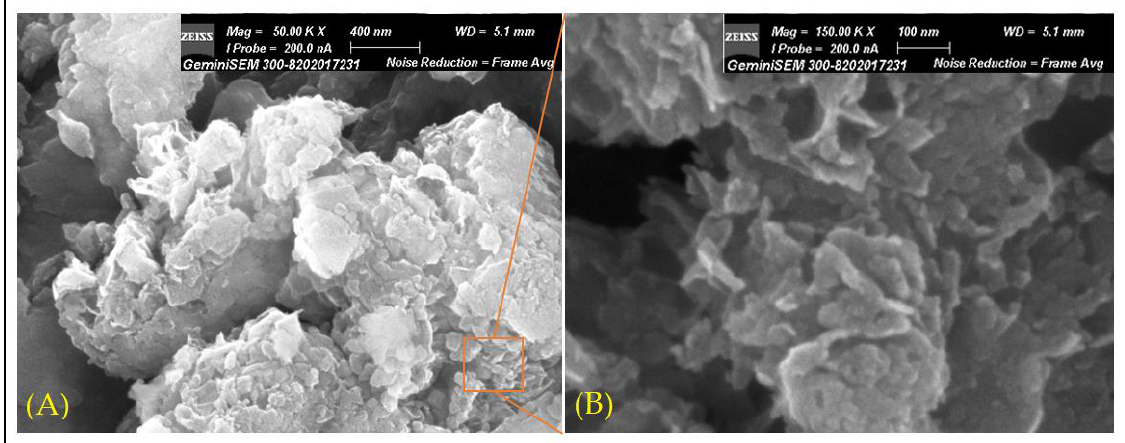
Figure 8. FESEM images 9 wt% g-C 3 N 4 /MoS 2 at magnifications of 400 nm ( A ) and 100 ( B ).